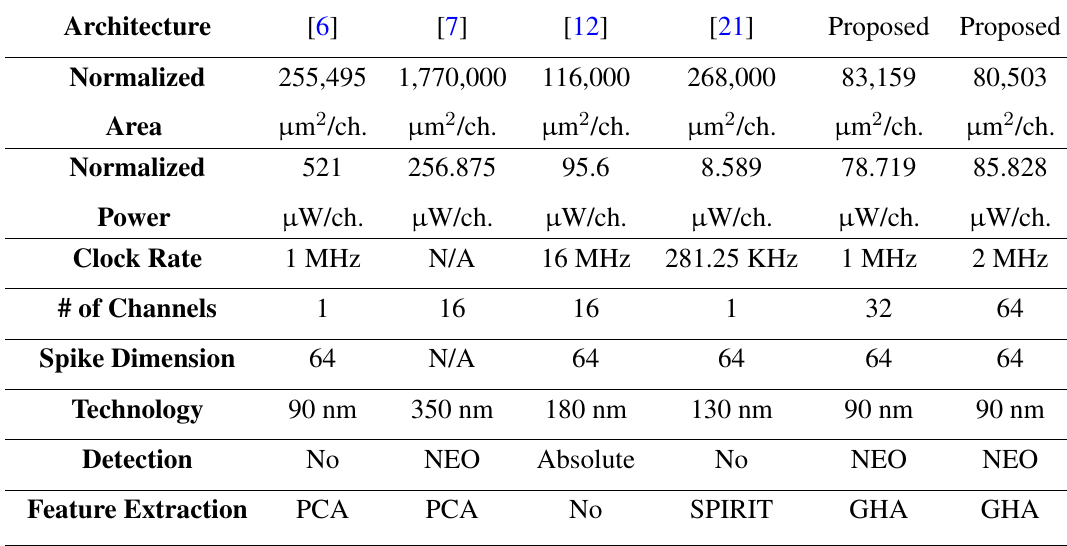
Table 9. Comparison between existing architectures and that proposed. SPIRIT, streaming pattern discovery in multiple